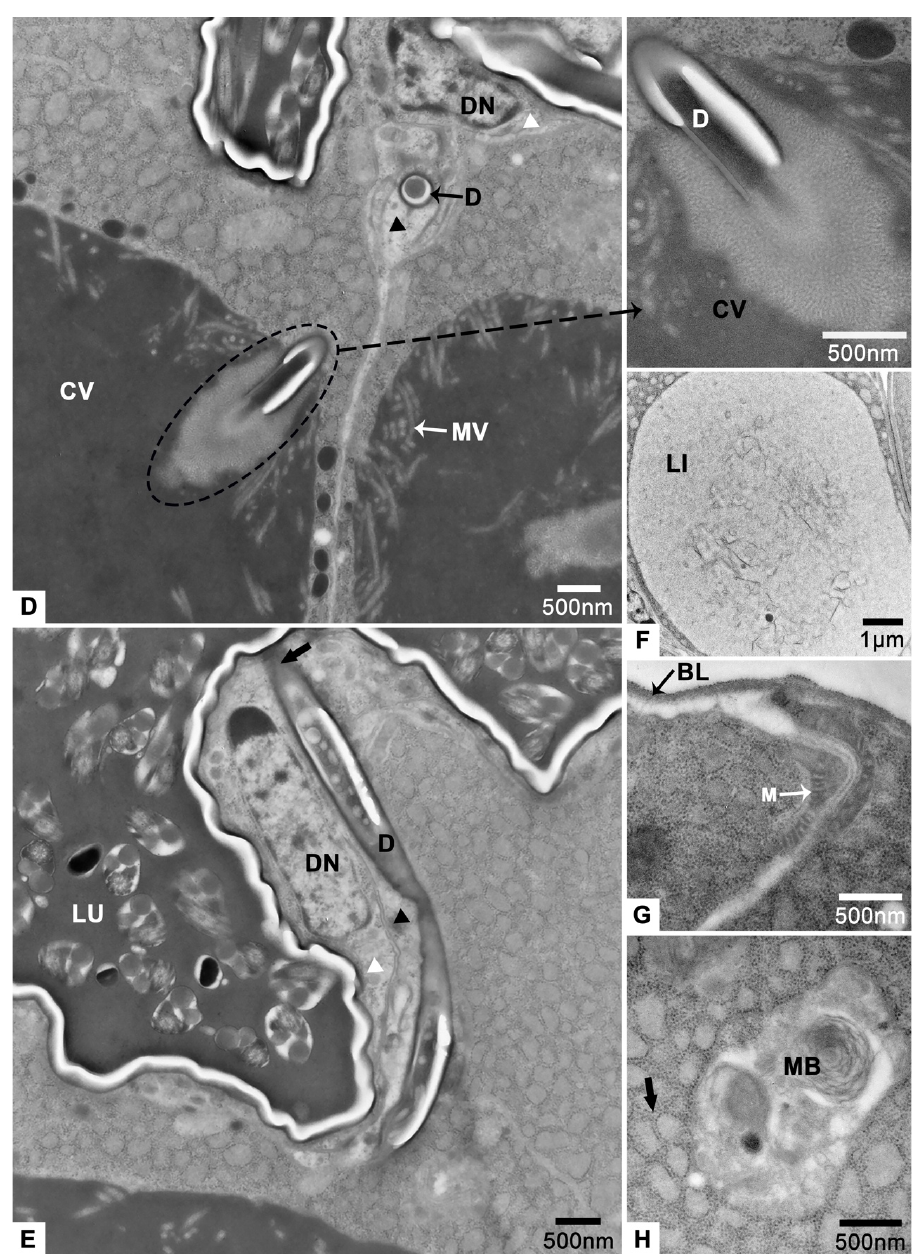
Figure 11. The spermathecal sac and the spermathecal pump of T. klimeschi on sixteenth day post-eclosion. ( A ) Longitudinal section of the spermathecal sac and the spermathecal pump, showing the valve that connects them. A large cavity bordered by microvilli is present in each secretory cell. ( B ) Sperm in the spermathecal pump. ( C ) Structure of the spermathecal sac, showing the presence of sperm in the lumen. ( D , E ) The cavity bordered by microvilli. In the dotted black circle, a duct protrudes from a secretory cell. The duct of secretory cell opening in the lumen (black arrow). The duct-forming cells (white triangles) are located next to the cuticle. The duct-forming cells (black triangles) are located next to the duct of secretory cell. ( F ) The light inclusion. ( G ) Mitochondria at the periphery of a secretory cell. ( H ) The reticulate endoplasmic reticulum (black arrow) and multilayer body. Spermathecal sac (SS); spermathecal pump (SP); valve (VA); nucleus of a secretory cell (SCN); basal lamina (BL); cuticle (CU); secretory cell (SC); light inclusion (LI); cavity (CV); nucleus of a duct-forming cell (DN); microvilli (MV); duct (D); lumen (LU); multilayer body (MB); and mitochondria